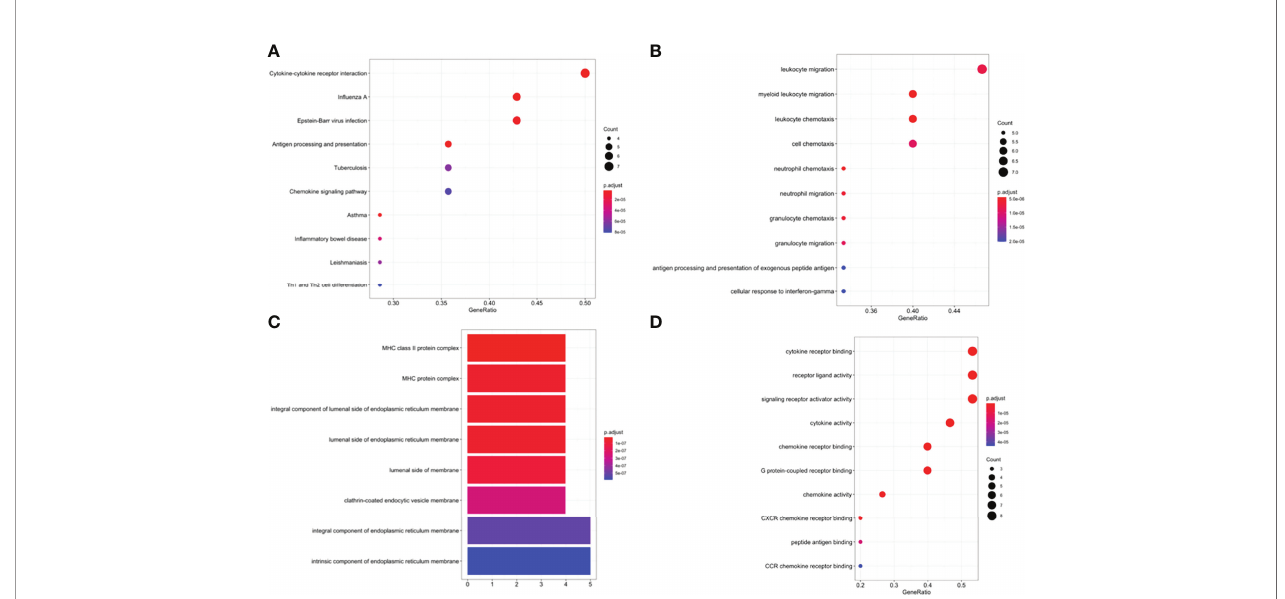
FIGURE 5 | (A) Enriched Kyoto Encyclopedia of Genes and Genomes (KEGG) pathways of DEIRGs. Enriched Gene Ontology (GO) pathways of DEIRGs. (B) BP biological process, (C) CC cell component, (D) MF molecular function.